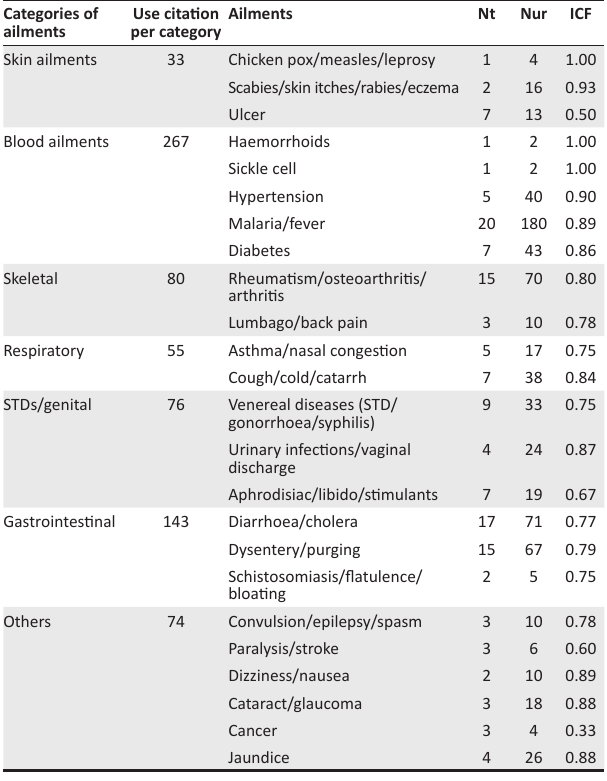
TABLE 3: Categories of ailments and their informant consensus factor. Categories of Use citation ailments per category